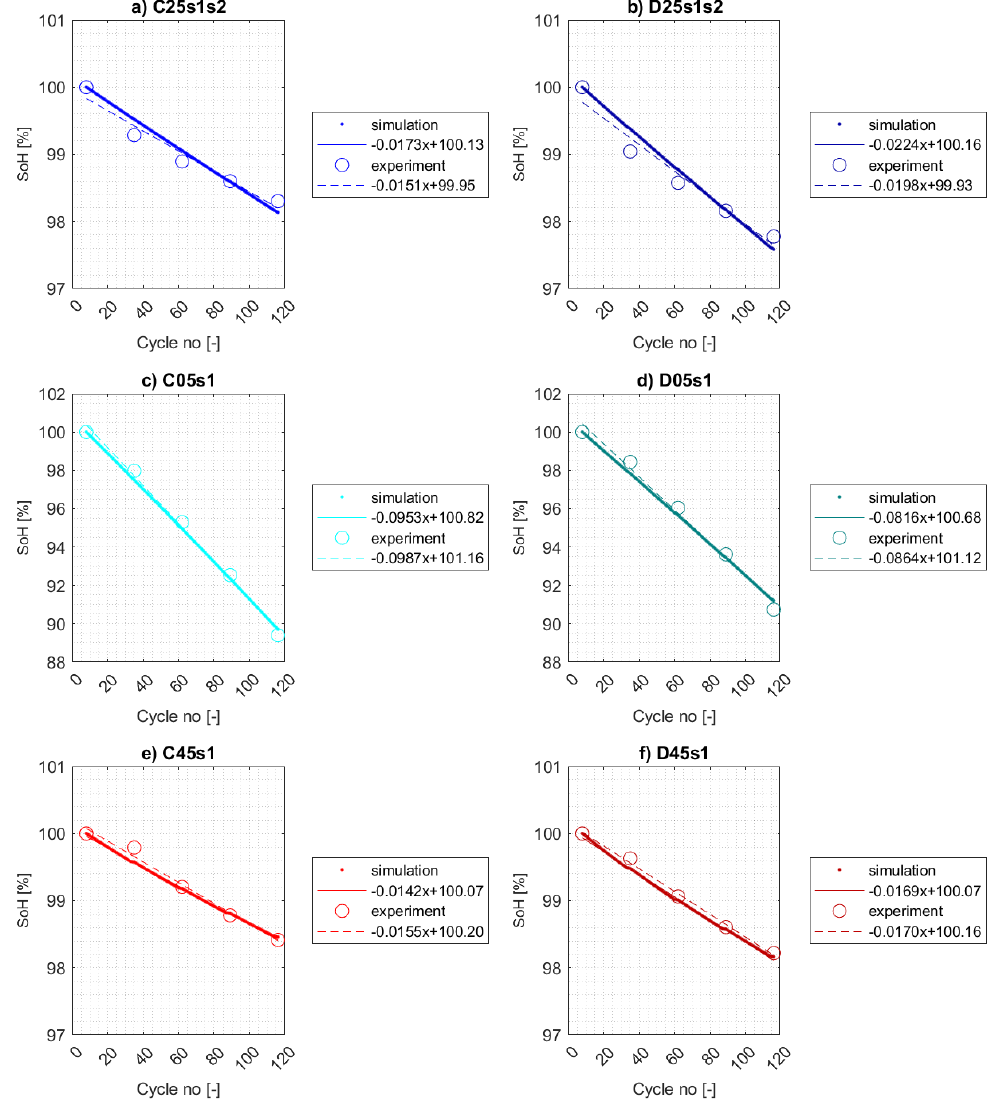
Figure 19. Comparison of the simulation and experimental SoH results for all the cycled cells at temperatures 25, 5 and 45 ◦ C. Simulations have been performed with the parameter values from the first adjustment according to Table